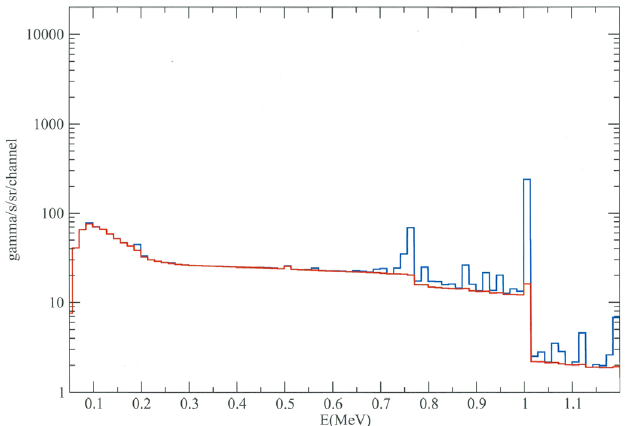
Fig. 4. Discrete uncollided lines (blue) with multigroup scattered background (red).